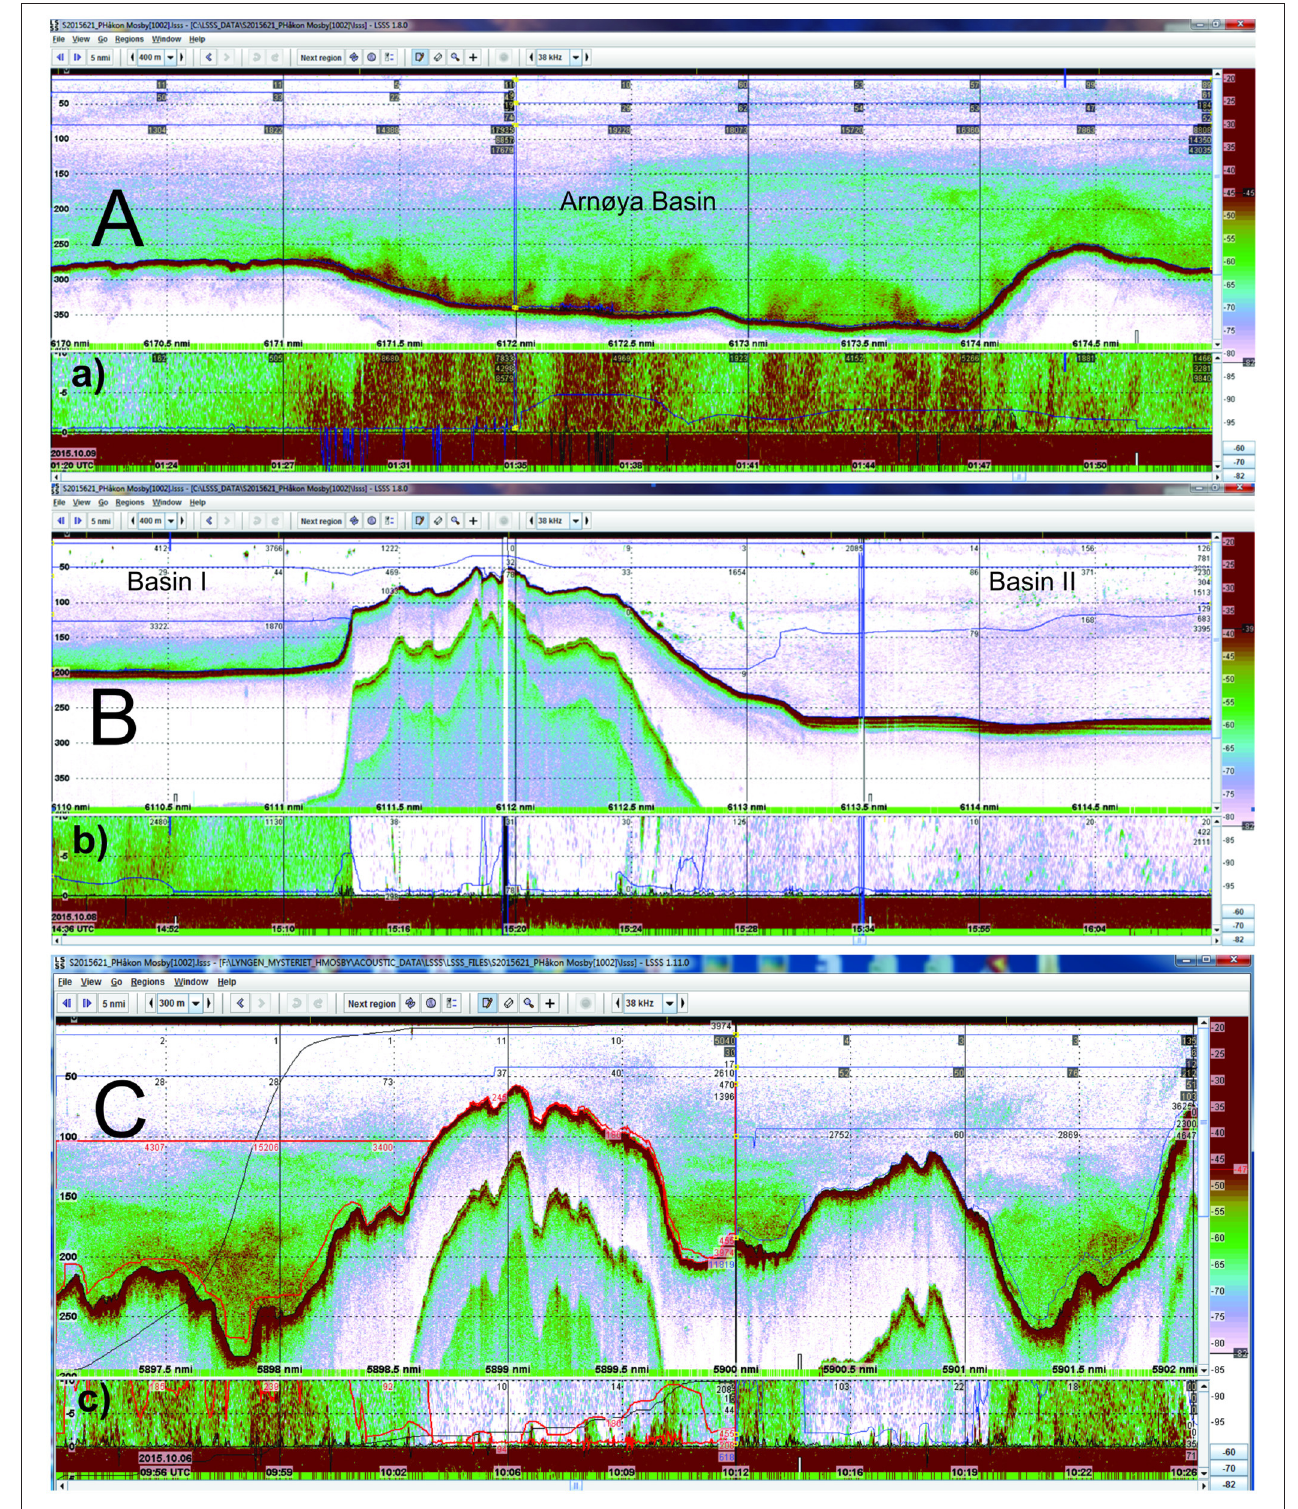
FIGURE 9 | Echograms obtained at 38kHz from RV Håkon Mosby in Lyngenfjord and nearby area. (A) Acoustic record between Arnøya and the tip of the Lyngen peninsula on 9 October 2015. (B) Acoustic record from the central part of Lyngenfjord crossing the sill from Basin I to Basin II in Lyngenfjord on 8 October. (C) Acoustic record from the outer coastal area west of the island Loppa on 6 October. Locations of echograms marked with bold black lines in Figure 1 . (a), (b), and (c) denote the bottom channel registrations in the nearest 10m to the bottom. The volume backscattering strength threshold in the echo integrator, Sv,t, = − 82 dB re 1 m − 1 .